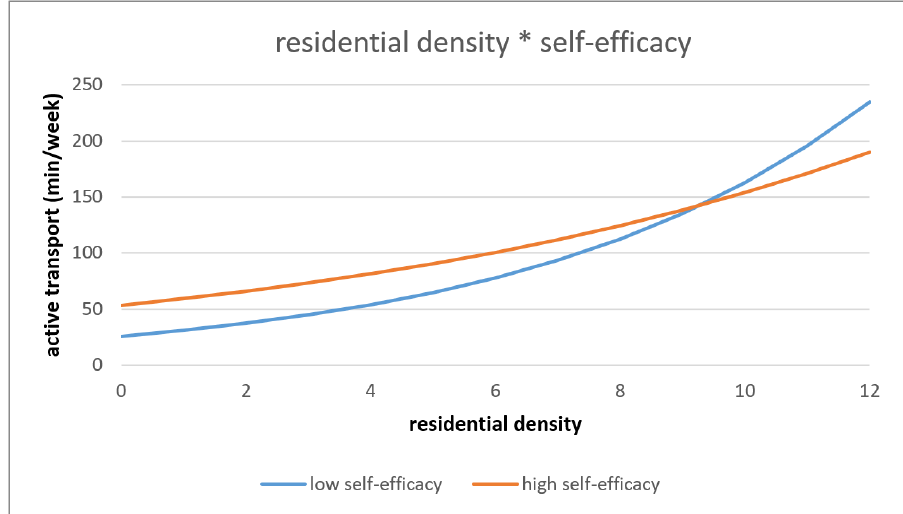
Figure 1. Interaction effect of residential density and self-efficacy on active transport.